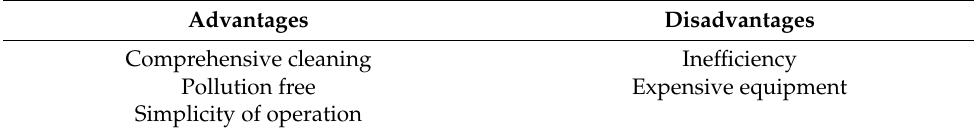
Table 5. The advantages and disadvantages of acoustic dry